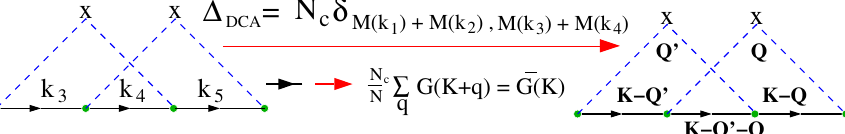
Figure 19. Use of the DCA Laue function Λ DCA leads to the replacement of the lattice propagators G ( k 1 ) , G ( k 2 ) , ... by coarse-grained propagators ¯ G ( K ) , ¯ G ( K (cid:48) ) , ... The impurity scattering dashed lines and unchanged by coarse-graining since the scatterings are